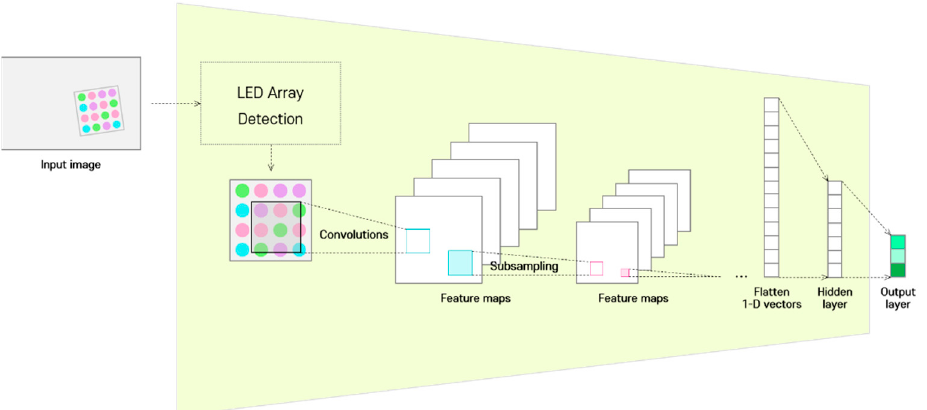
Figure 2. Structure of the channel identification module.